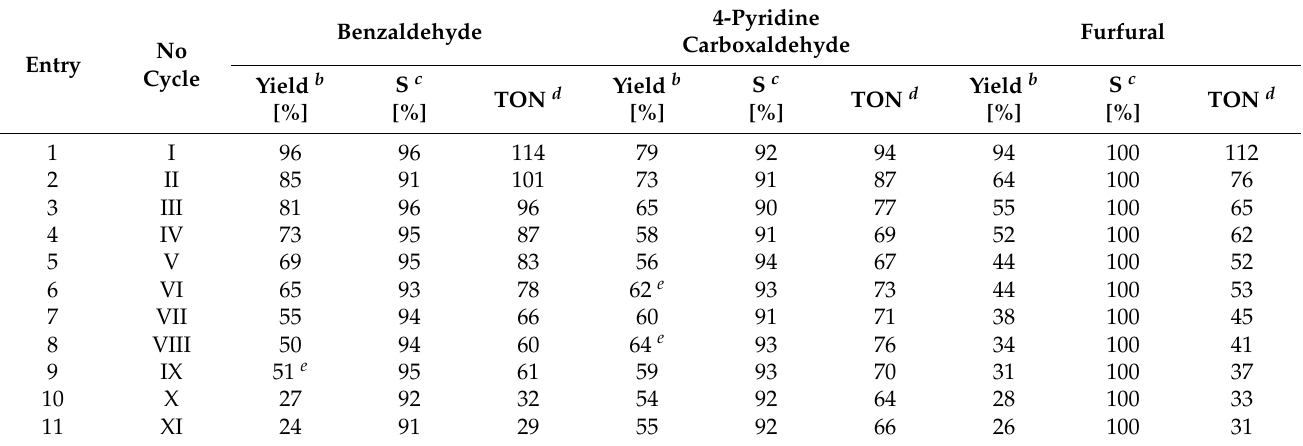
Table 4. The reusability of N-AgNPs in catalytic oxidation of selected primary aromatic alcohols to aldehydes a .